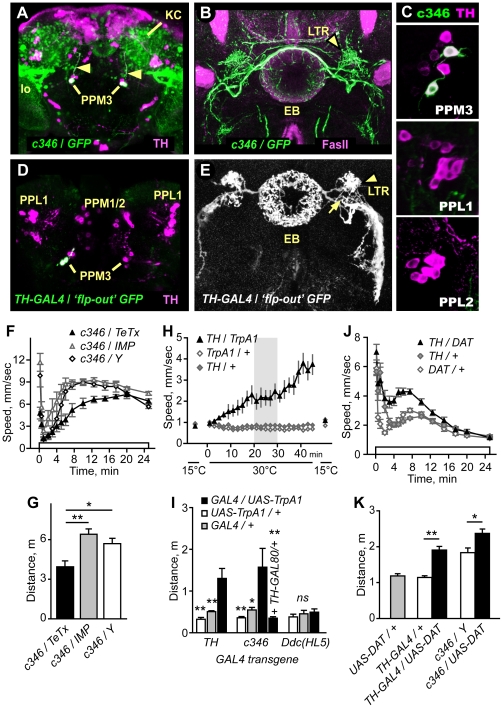
TH-positive PPM3 neurons that project to the ellipsoid body promote ethanol-induced hyperactivity.
A. c346 (detected by UAS-GFP, green) was expressed in two TH-positive (magenta) PPM3 neurons per hemisphere. The c346 PPM3 processes projected anteriorly (arrowheads) towards the central complex. c346 was also detected in the mushroom body Kenyon cells (KC) and in neurons that projected to the lobula (lo). B. c346 (green) processes project to the lateral triangles (LTR) and ring of the ellipsoid body (EB), counterstained with FasII (magenta). C. c346 expression in TH-positive cells is limited to the PPM3s. D,E. Labeling of individual TH-GAL4 cells using the flp-out technique. Two GFP-labeled TH cells in the PPM3 cluster projected anteriorly to the LTR region (entry point is marked with an arrow in E). The process branched to innervate the EB ring and LTR, and the ventral body region. F,G. Distance traveled was reduced in c346/TeTx (*P<0.05, **P<0.01, 1-way ANOVA, Tukey's multiple comparison test) whereas the startle response was not (P = 0.0925, 1-way ANOVA, n≥6). H. Transient activation of TH neurons increased locomotor activity. Expression of the heat-activated TrpA1 ion channel in TH neurons at 15°C (off) and 30°C (on). I. Distance traveled from 20–30 min at 30°C for TH/TrpA1 (**P<0.01, 1-way ANOVA, Dunnett's multiple comparison test, n≥5). c346/TrpA1 also increased locomotor activity. Flies of the genotype c346/Y;TH-GAL80/+;UAS-TrpA1/+, where GAL4 activity was blocked by GAL80 solely in c346 PPM3 neurons, showed no increase in locomotor activity (*P<0.05, **P<0.01, 1-way ANOVA, Dunnett's multiple comparison test to c346/Y; UAS-TrpA1/+, n≥6). Activation of TrpA1 in the Ddc(HL5) pattern had no effect (P = 0.6243, 1-way ANOVA, n≥5). J,K. Overexpression of DAT in TH-GAL4 or c346 neurons increased ethanol-induced hyperactivity. (*P = 0.0123, **P = 0.0005, 2 sample t-test, n≥10).